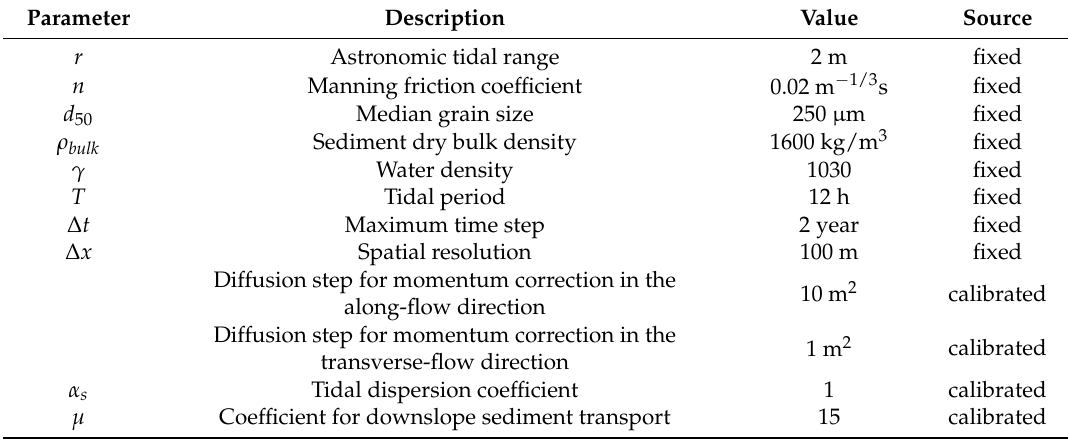
Figure 1. Scheme of the CM2D model, including both hydrodynamic and morphodynamic processes. The red text highlights the sediment transport mechanisms. Table 1. Reference parameters used in the model CM2D.